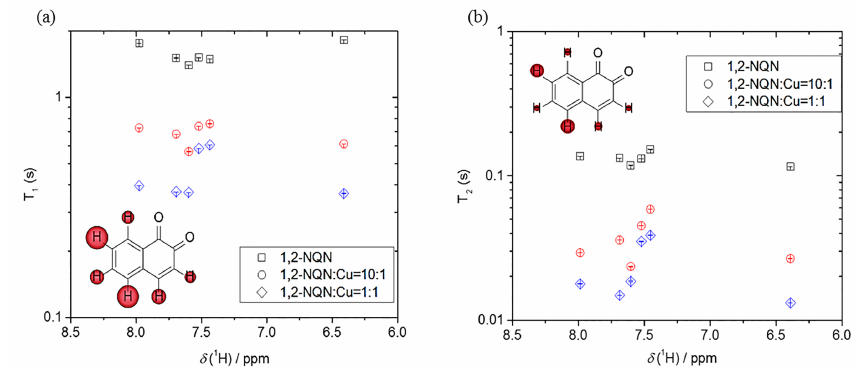
Figure 11. 1 H NMR relaxometry analyses for (a) T1 and (b) T2 of 1,2-NQN mixed with Cu (II) at different ratios: 1,2-NQN with no Cu (black), Cu (II): 1,2-NQN = 1:10 (red), and Cu (II): 1,2-NQN = 1:1 (blue). Both T1 and T2 decreased when Cu was introduced into the system, indicating a smaller scale of nuclear spin dynamic resulted from organic–metal binding. The molecular epitopes illustrate the influence of Cu (II) binding on an individual proton. A smaller sphere shadow on a proton denotes a larger relaxation influence from Cu (II)–organic